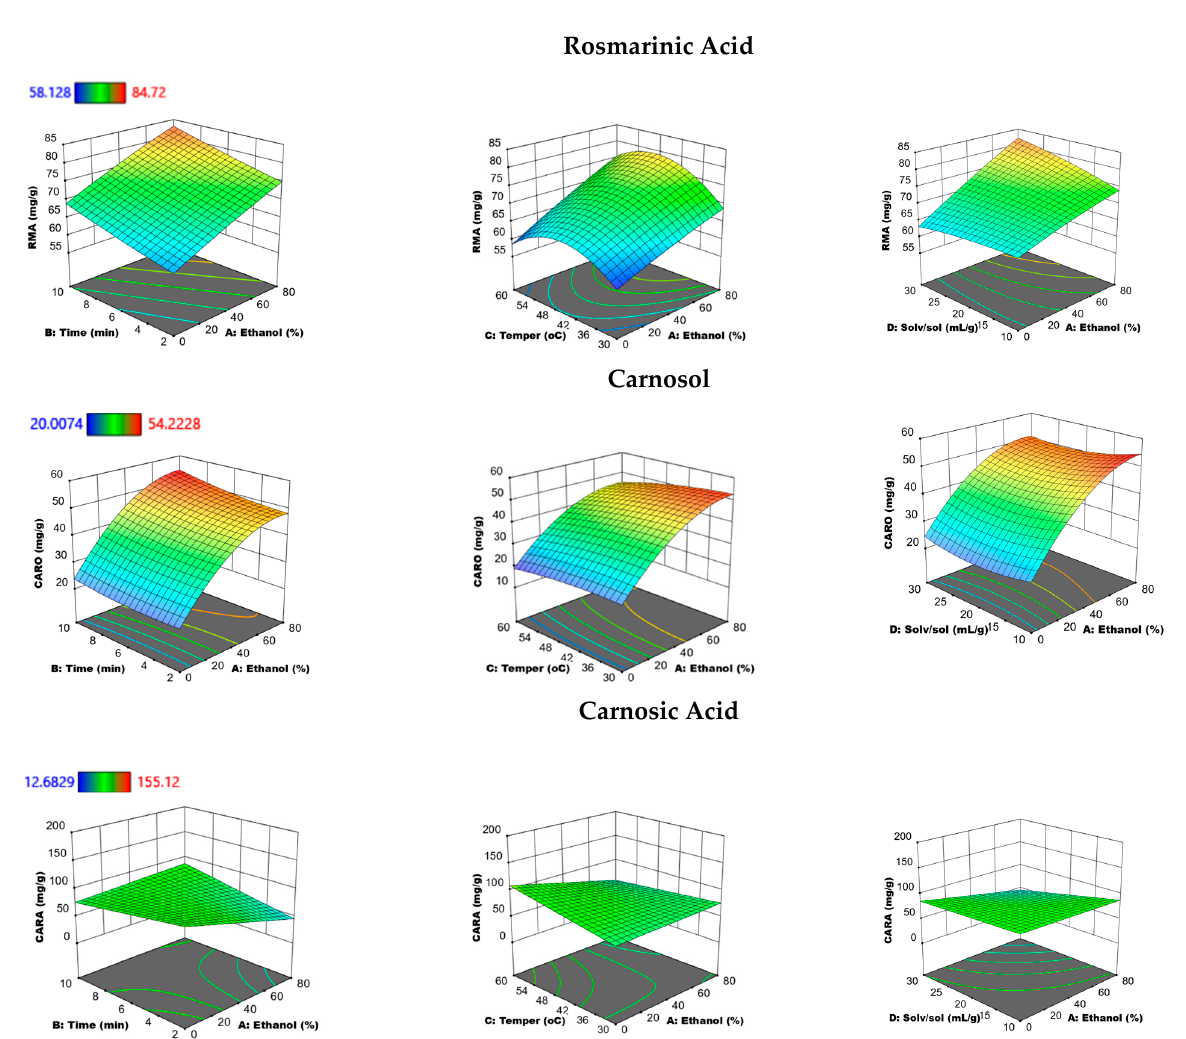
Figure 5. Response surface plots showing the combined effects of the UAE parameters (% ethanol-time, % ethanol-temperature, and % ethanol solvent-to-solid ratio) on rosmarinic acid (RMA), carnosol (CARO), and carnosic acid (CARA) by keeping the two independent variables constant at medium levels.